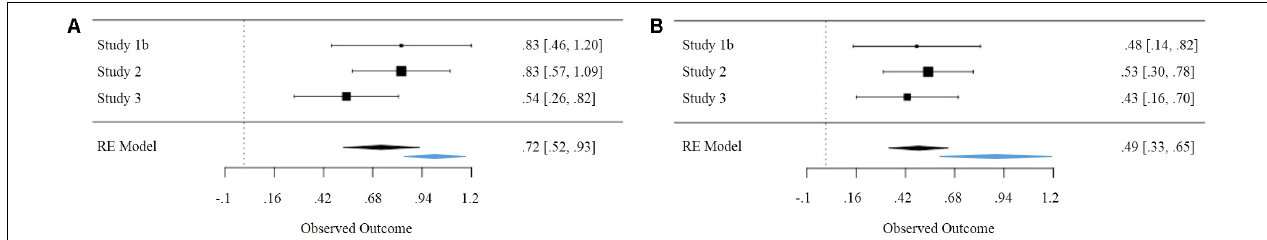
FIGURE 5 | Confidence interval of the effect sizes in each study and confidence intervals of the meta-analytic average. Negative values would correspond to category-based learning and positive values to individual-based learning. Blue areas represent the effect size observed with consistent individuals, 0.97 and 0.89, respectively, for ingroup and outgroup trustees. (A) Ingroup Inconsistent Condition. (B) Outgroup Inconsistent